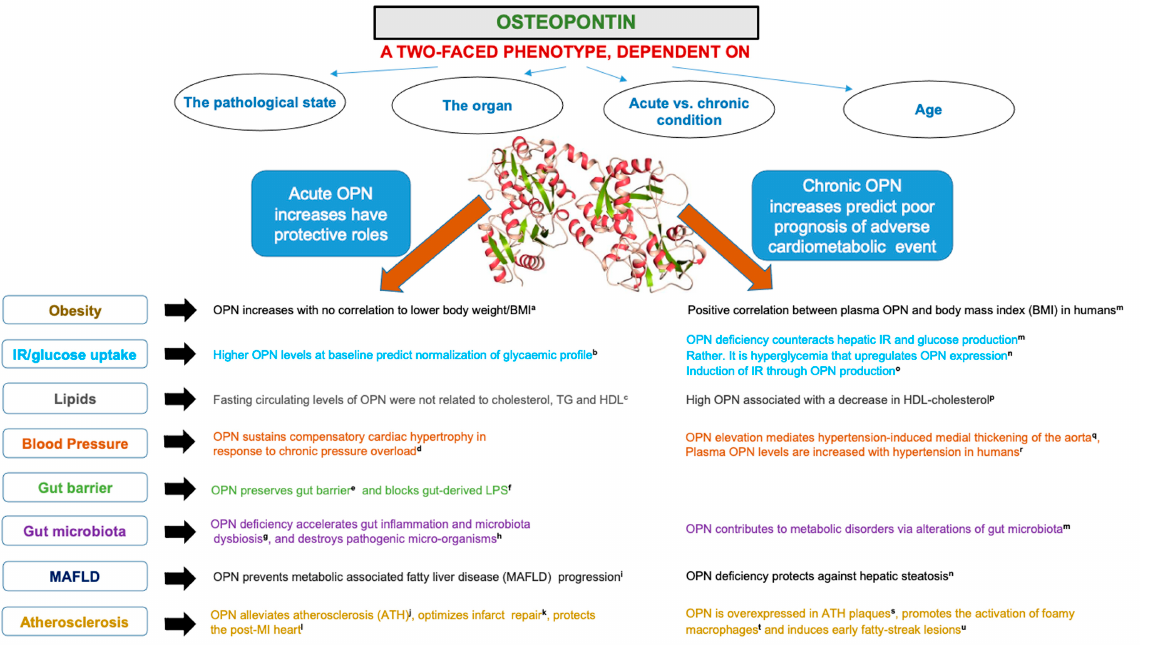
Figure 2. Biological functions of bioactive milk osteopontin. Related references cited in the